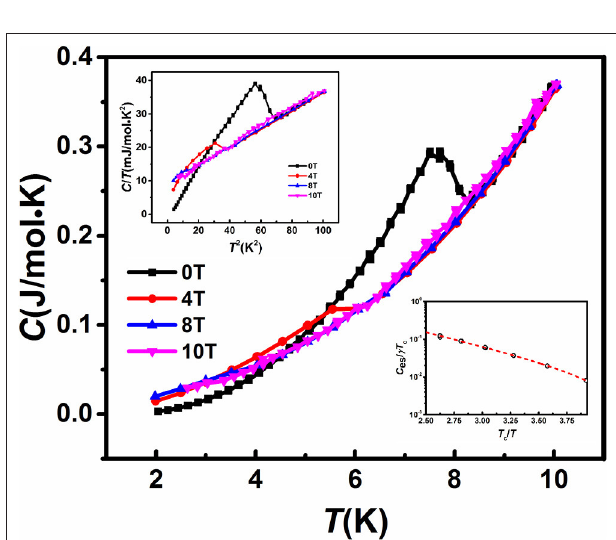
0, 4, 8 and 10T. The upper inset =